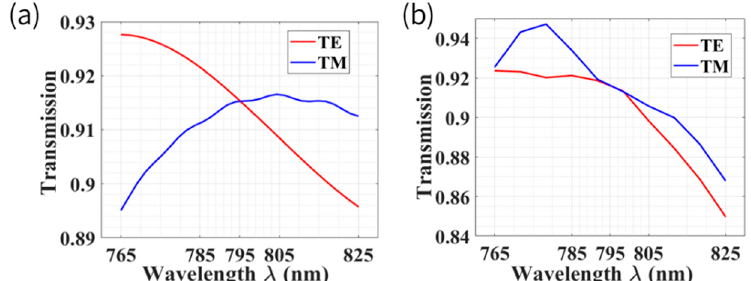
Figure 9. ( a ) Spectral response of the proposed mode converter with a length of 121.5 μ m. ( b ) Spectral response of the optimized inverse taper with a length of 774.1 μ m.